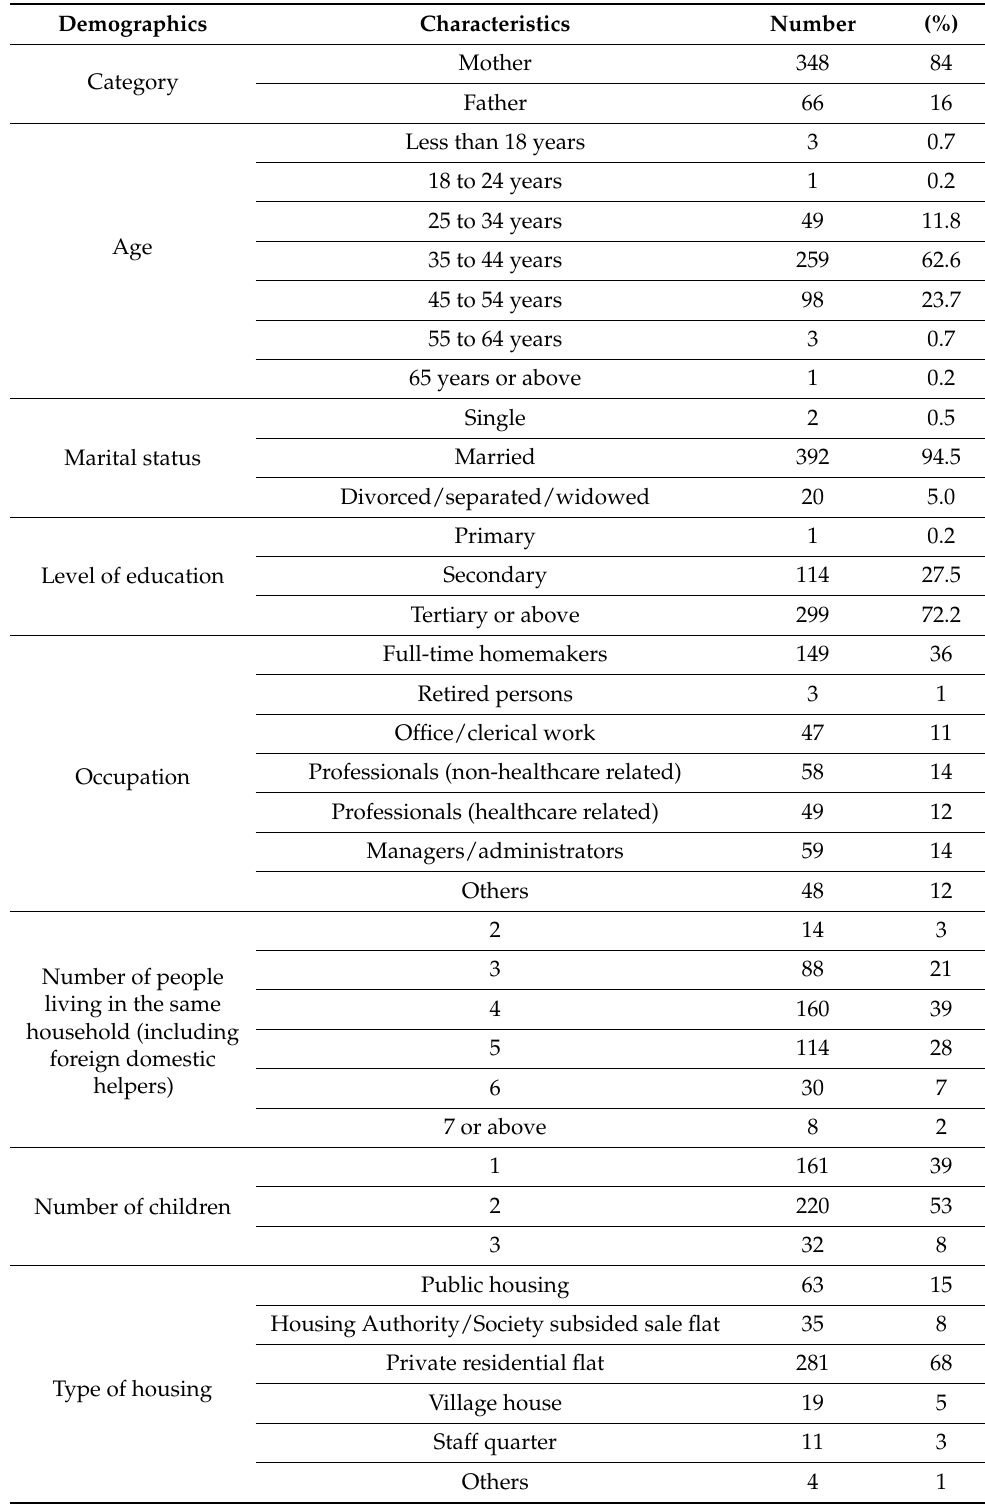
Table 1. Demographics of the